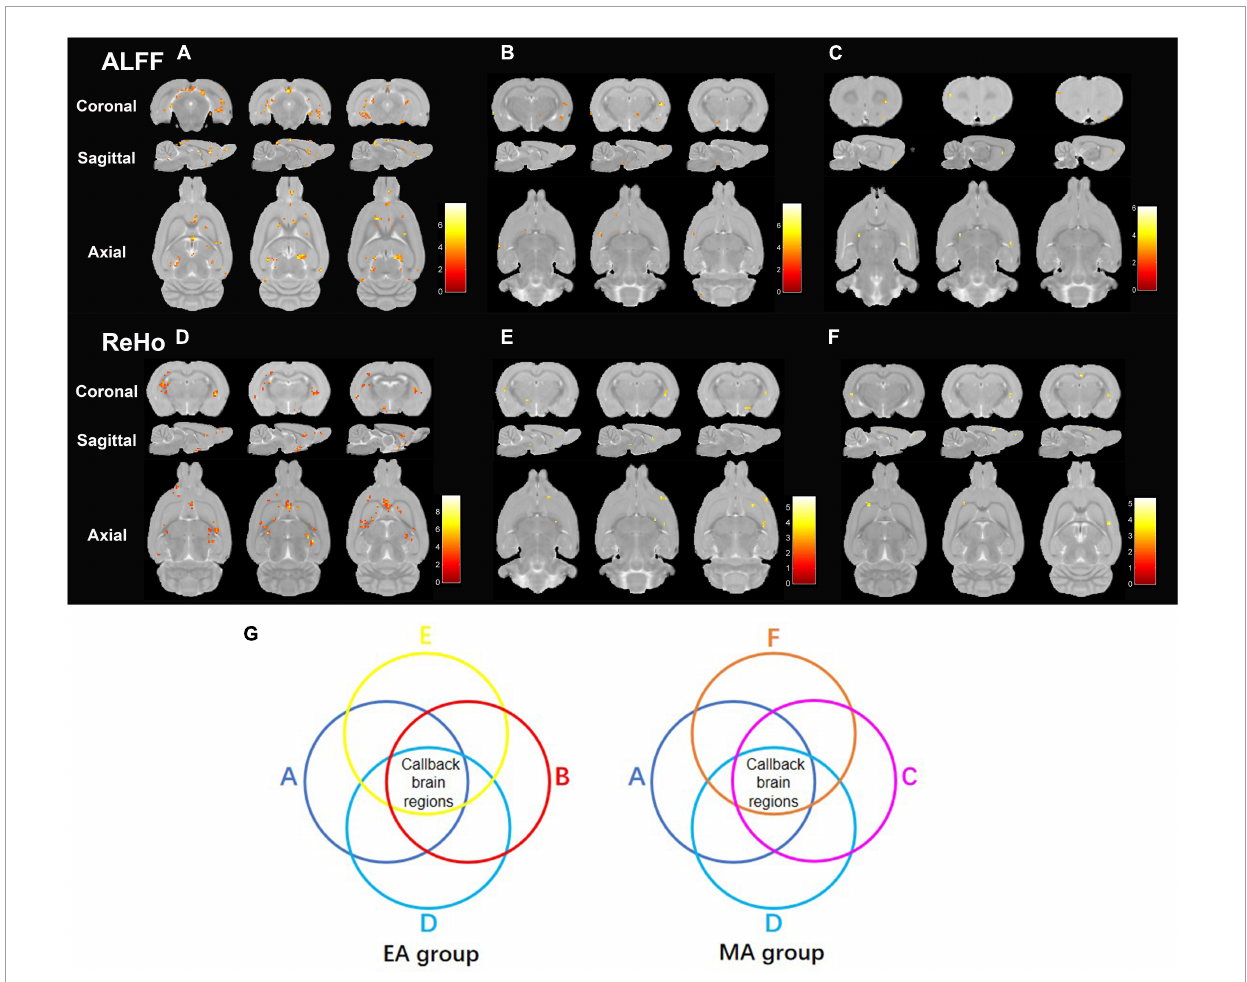
FIGURE3 Electroacupuncture and manual acupuncture activate callback brain regions regulating blood pressure and cognitive functions of spontaneously hypertensive rats (SHRs). ALFF and ReHo analyses were performed in the Wistar–Kyoto (WKY), SHR, EA, and MA groups. (A) The brain regions with decreased ALFF values in SHR compared to that in WKY. (B) The brain regions with increased ALFF values in EA compared to that in SHR. (C) The brain regions with increased ALFF values in MA compared to that in SHR. (D) The brain regions with decreased ReHo values in SHR compared to that in WKY. (E) The brain regions with increased ReHo values in EA compared to that in SHR. (F) The brain regions with increased ReHo values in MA compared to that in SHR. Differential brain regions are displayed sequentially on the coronal plane, sagittal plane, and axial plane ( p < 0.005, uncorrected, Cluster > 5). Color bars signify the t value of the group analysis (brighter color represents a higher t value). (G) The process of determining the callback brain regions. WKY, normal-control group; SHR, model group; EA, electroacupuncture group; MA, manual acupuncture group; ALFF, the amplitude of low-frequency fluctuation; ReHo, regional